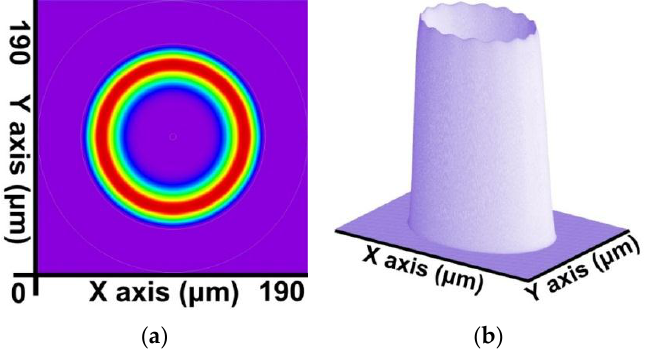
Figure 11. The 2D and 3D power distribution patterns of the cladding modes (v = 30) with an effective refractive index of 41.42949353 30 eff n . ( a ) The 2D power distribution; ( b ) the 3D power distribution.